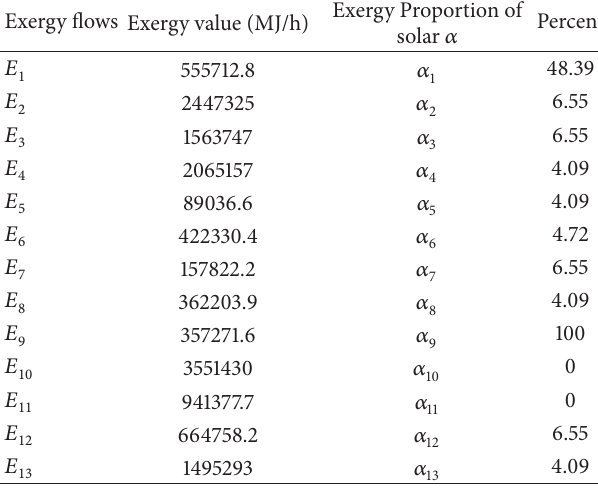
Table 5: Exergy value of each flow and the proportion of solar power.